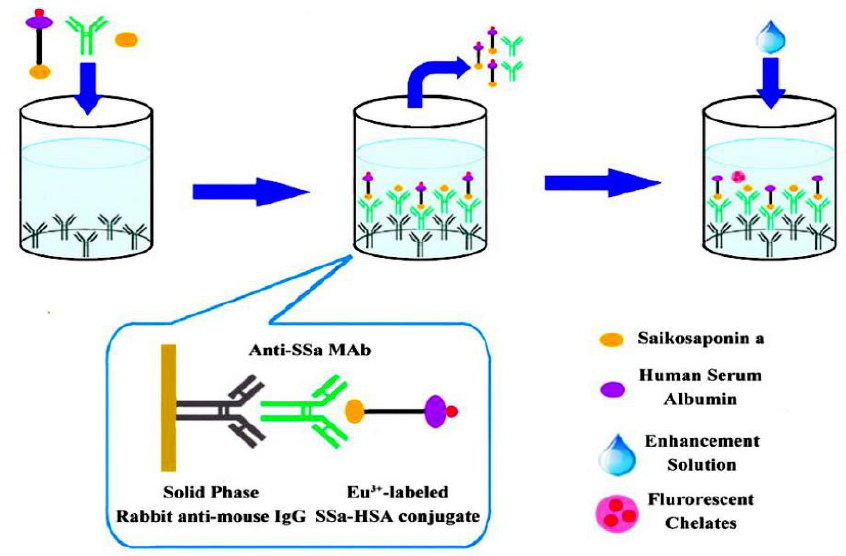
Figure 9. Schematic diagram of the TRFIA system for SSa detection [128].